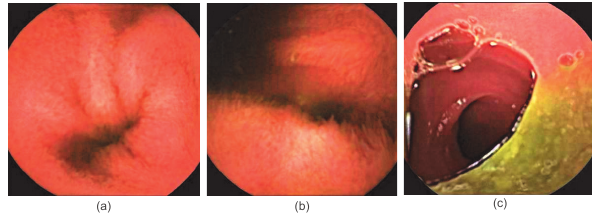
Fig. 2. Wireless capsule endoscopy images